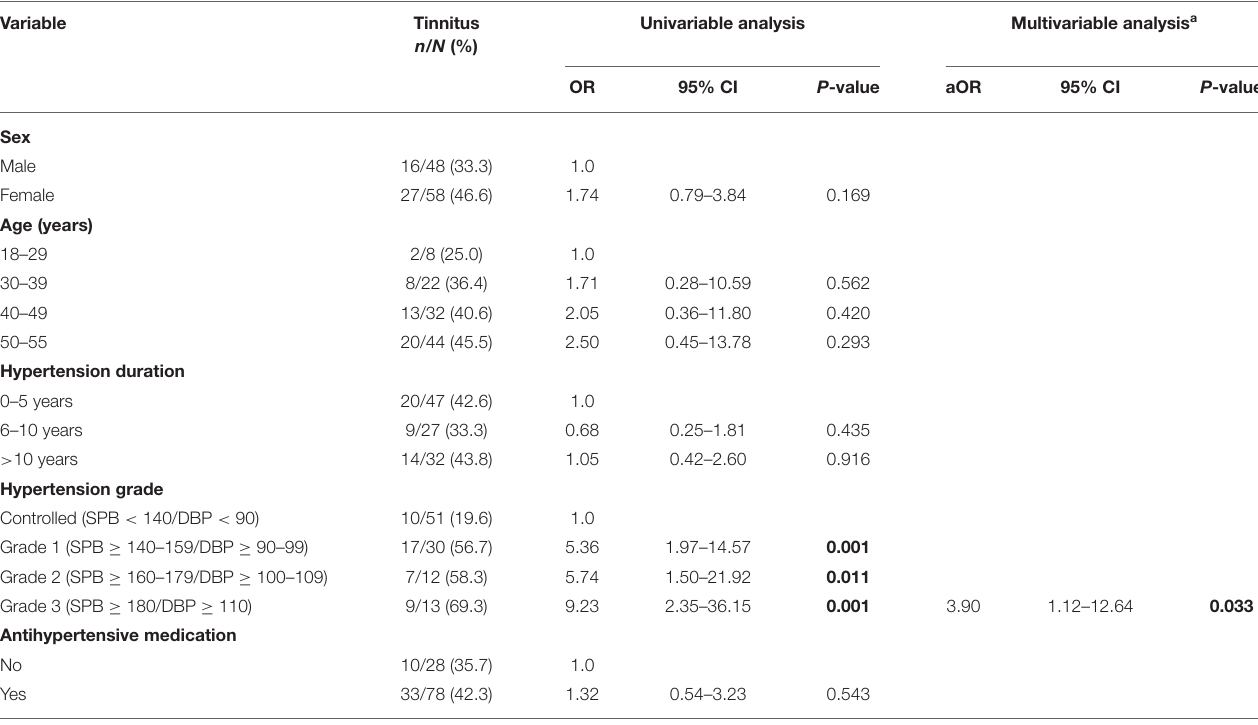
TABLE 5 | Univariate and multivariate logistic regression analysis of factors associated with tinnitus among hypertensives. Variable Tinnitus Univariable analysis Multivariable analysis n / N (%)